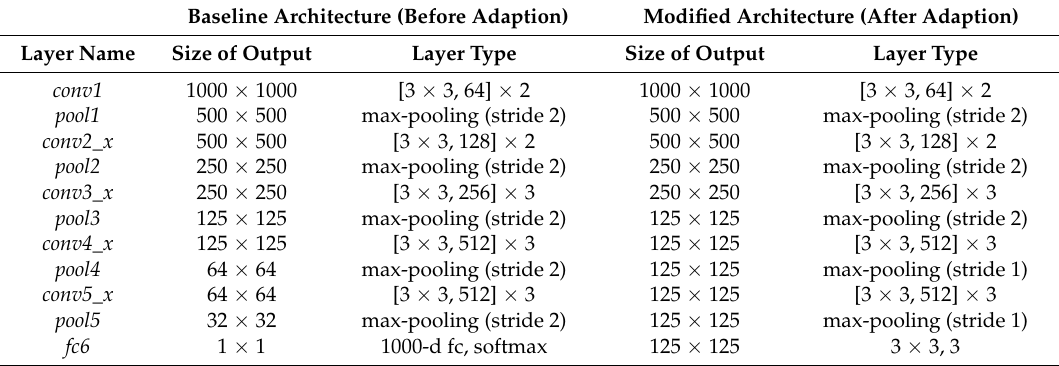
Table 3. Architectures of VGG-16 net before and after